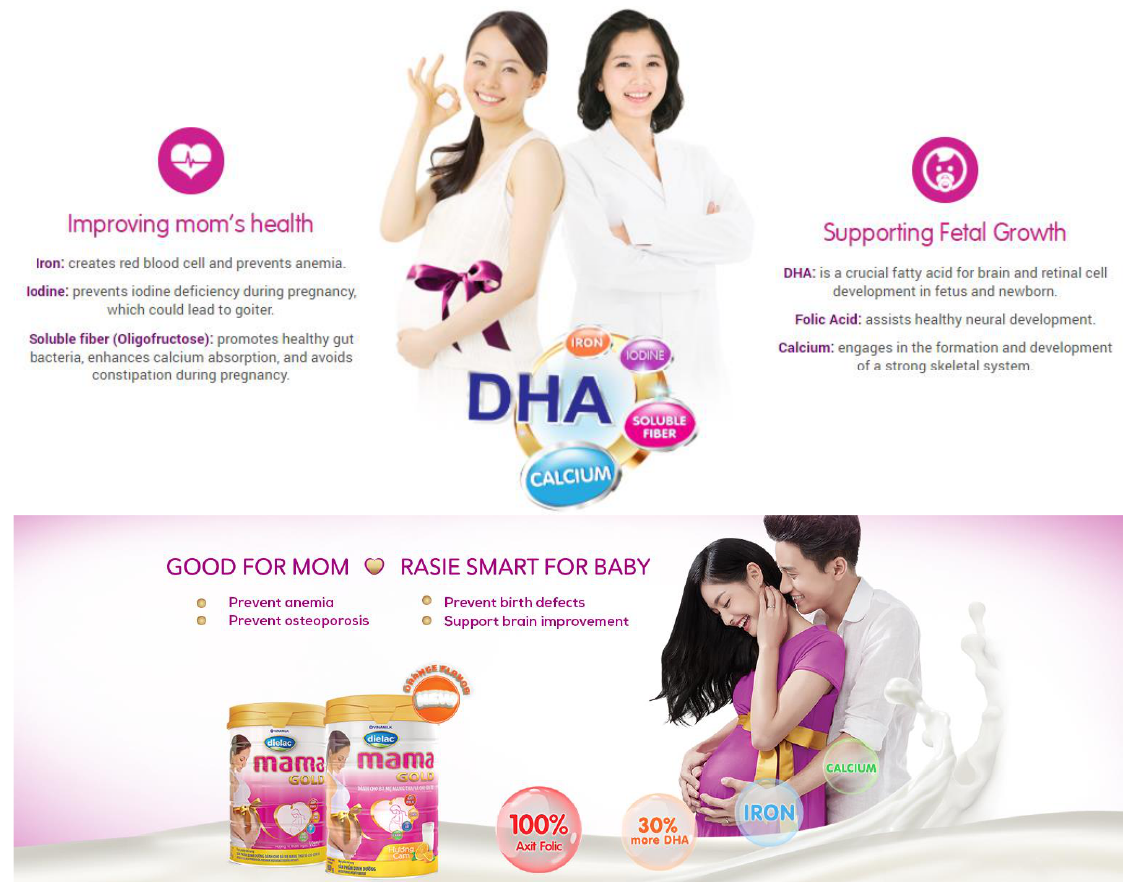
Figure 4. Dielac Mama Gold claims product benefits health of mother, fetus, and newborn [21].